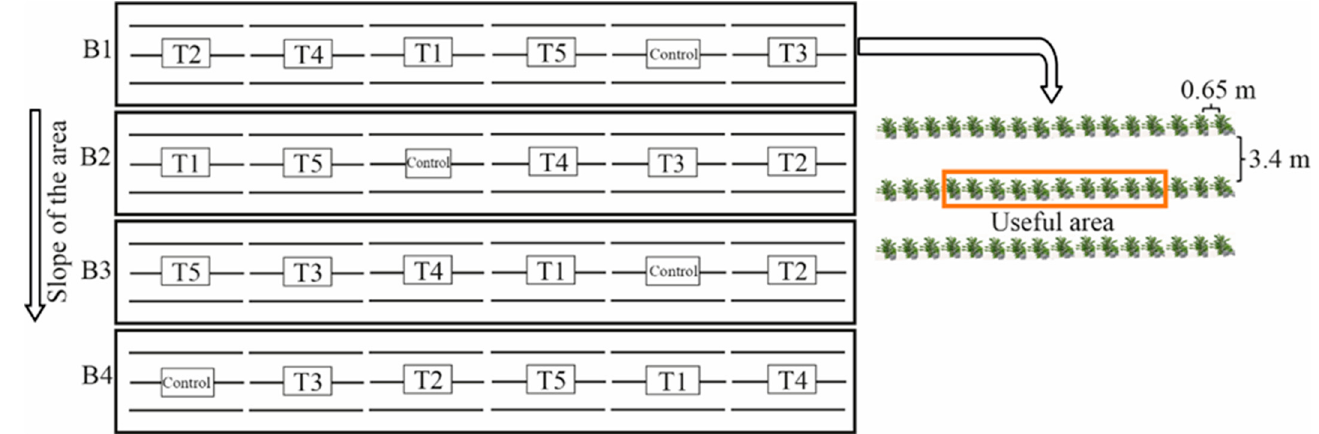
Figure 11. Schematic representation of the experimental design, number of plants in each plot, and the useful area used to collect the data.